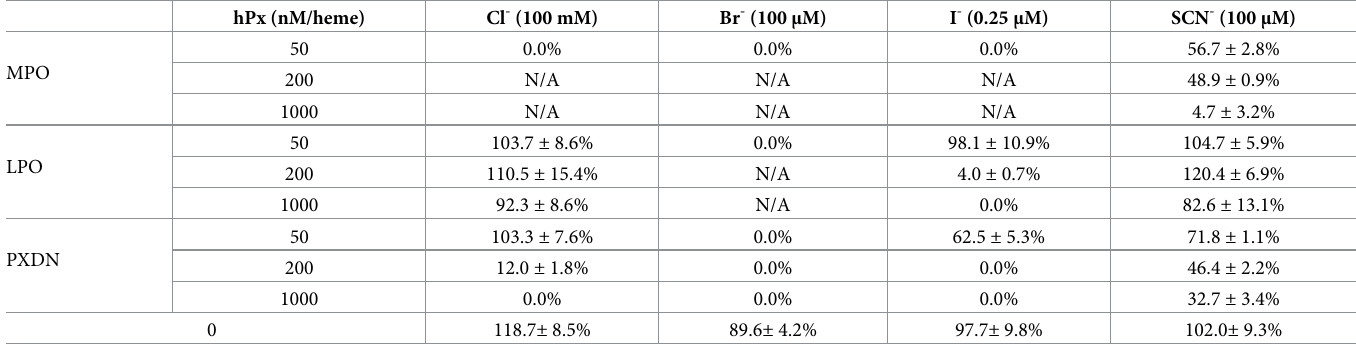
Table 1. Bactericidal activities of PXDN, MPO and LPO. E . coli K12 was incubated in 50 mM phosphate buffer (pH 6.2) containing halide anion (Cl - , Br - or I - ), 10 μ M H 2 O 2 , and indicated amount of hPx at 37˚C for 1 h. Cell mixtures were plated on LB agar plates and incubated at 37˚C overnight. The negative control experiment con- tained E . coli only. The CFUs were counted. The relative survival rate (%) was calculated as CFUs in the experimental group divided by those in the negative control. Data are representatives of at least three independent